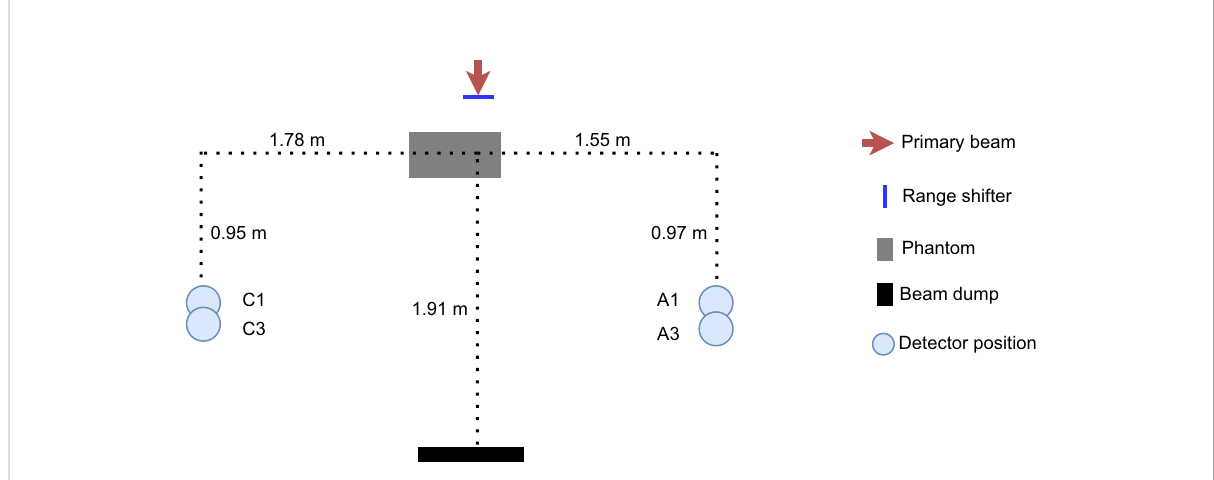
FIGURE 1 Schematic drawing of the experimental setup, to scale. Two detectors were used during the irradiation: one was placed on the C side, situated out toward the treatment room, and the other was situated at position A, close to the gantry wall, The phantom was positioned with its centre 15 cm from the beam